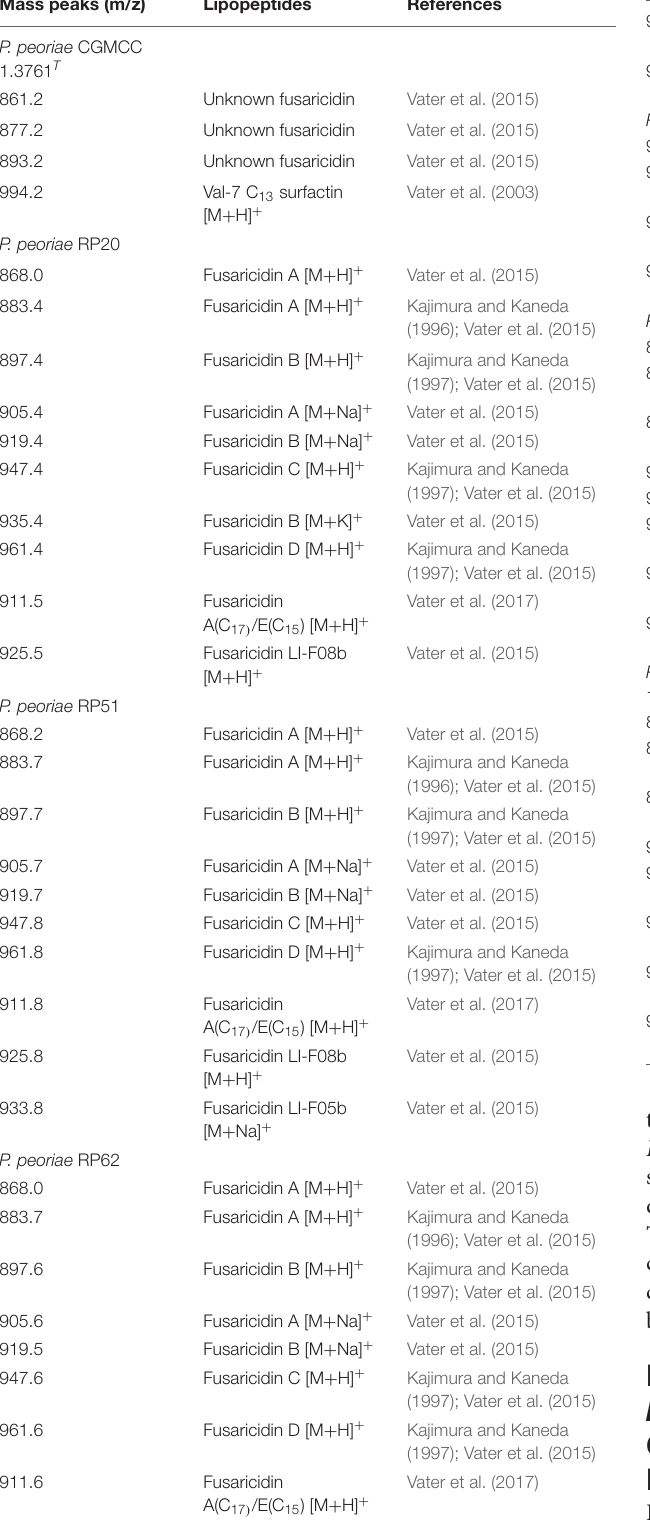
TABLE 3 | Lipopeptides identified by MALDI-TOF MS from strains within the Paenibacillus polymyxa complex. Mass peaks (m/z) Lipopeptides